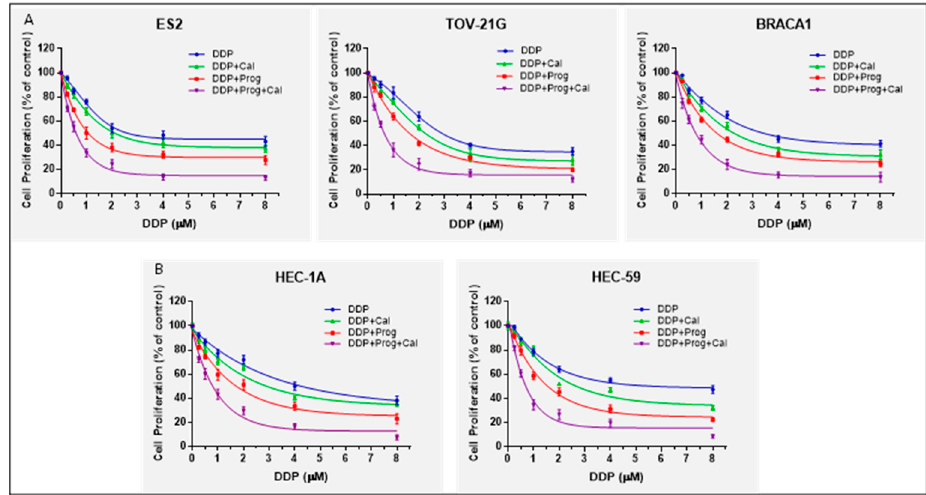
Figure 1. Progesterone-calcitriol combination inhibited cell proliferation and enhanced the inhibitory effect of DDP. Ovarian ( A ) and endometrial ( B ) cancer cells were exposed to various concentrations of DDP (0–8 µ M) alone or in the presence of either progesterone (20 µ M), calcitriol (30 nM), or the combination of the two for 76 h. Cell viability was measured by MTS assay. The experiment was repeated three times, and a representative experiment is shown. Data are mean ± SEM. An asterisk designates statistically significant differences between the control and treatment groups * ( p < 0.05).